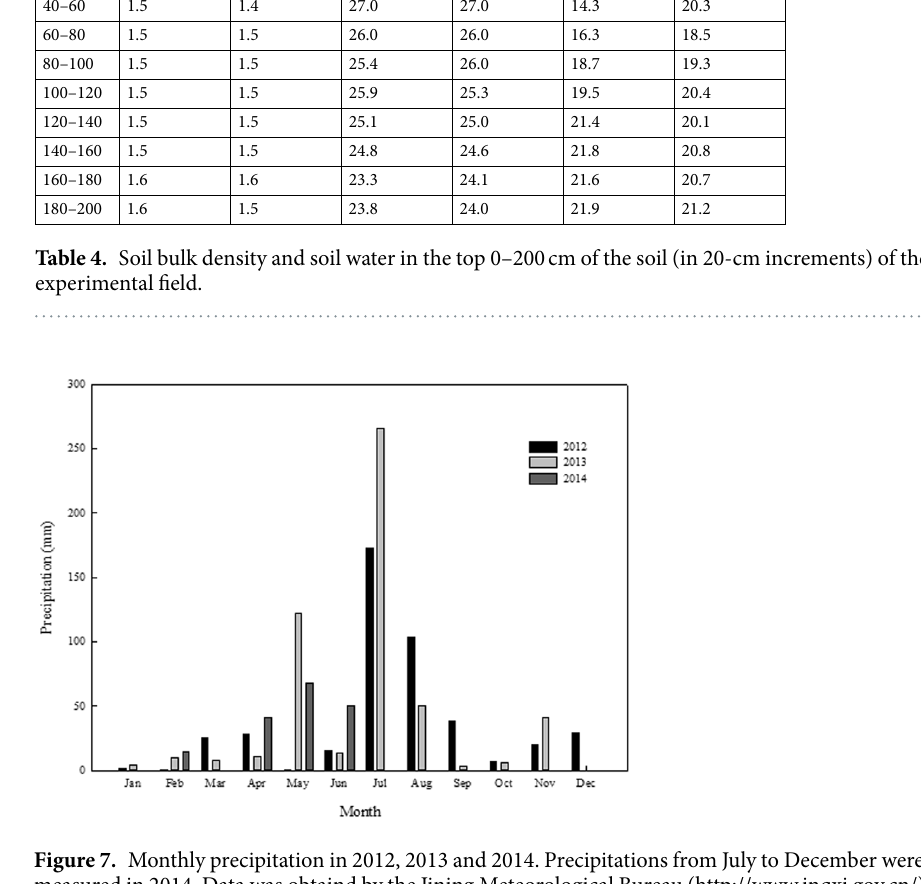
Soil Soil bulk density (g cm − 3 ) layers (cm)